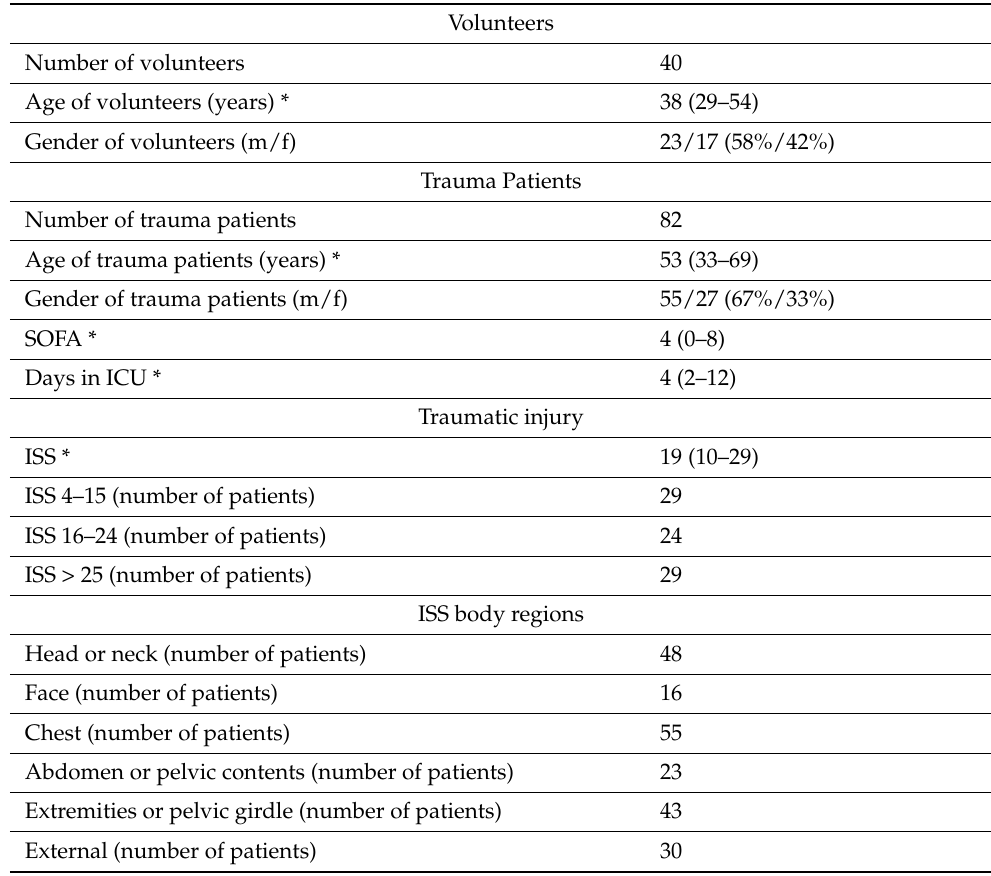
Table 1. Basic demographic data of volunteers as well as demographics and clinical scoring data of the injured patients. * Median with interquartile